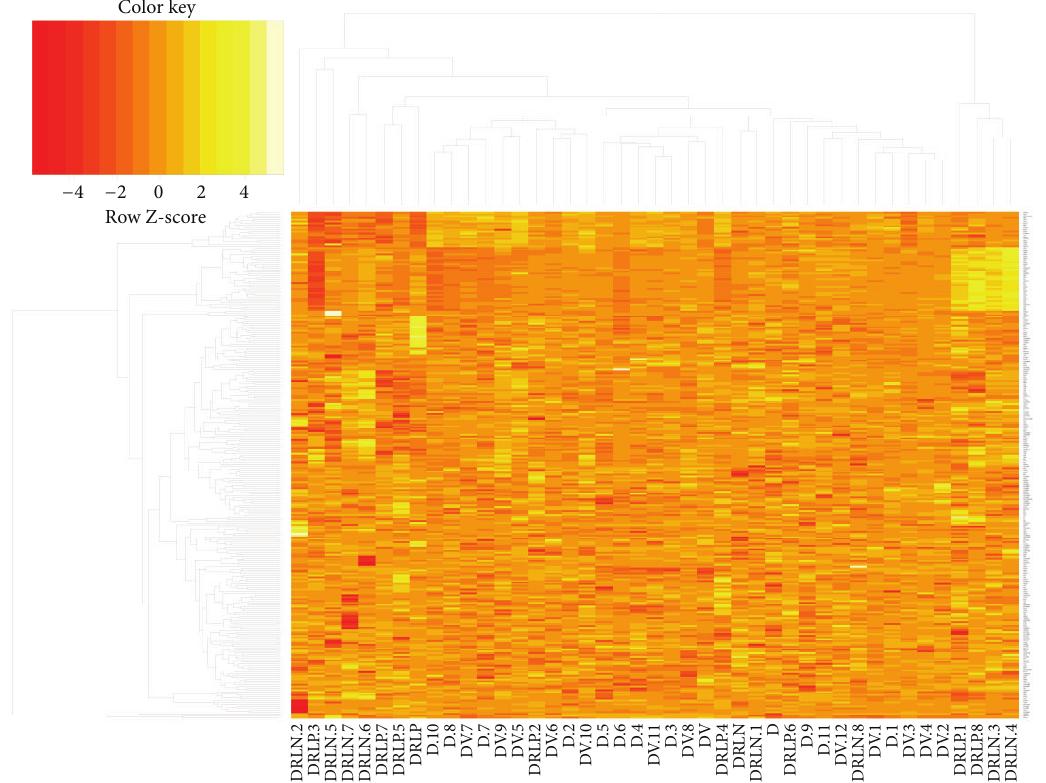
Figure 2: Genes differentially activated in each group (cluster formation). The enhanced gene expression heatmap was constructed using probe signal intensities that had a log fold change that was greater than +1 or less than − 1. Genes that were significantly altered in the relatives group clustered into specific gene